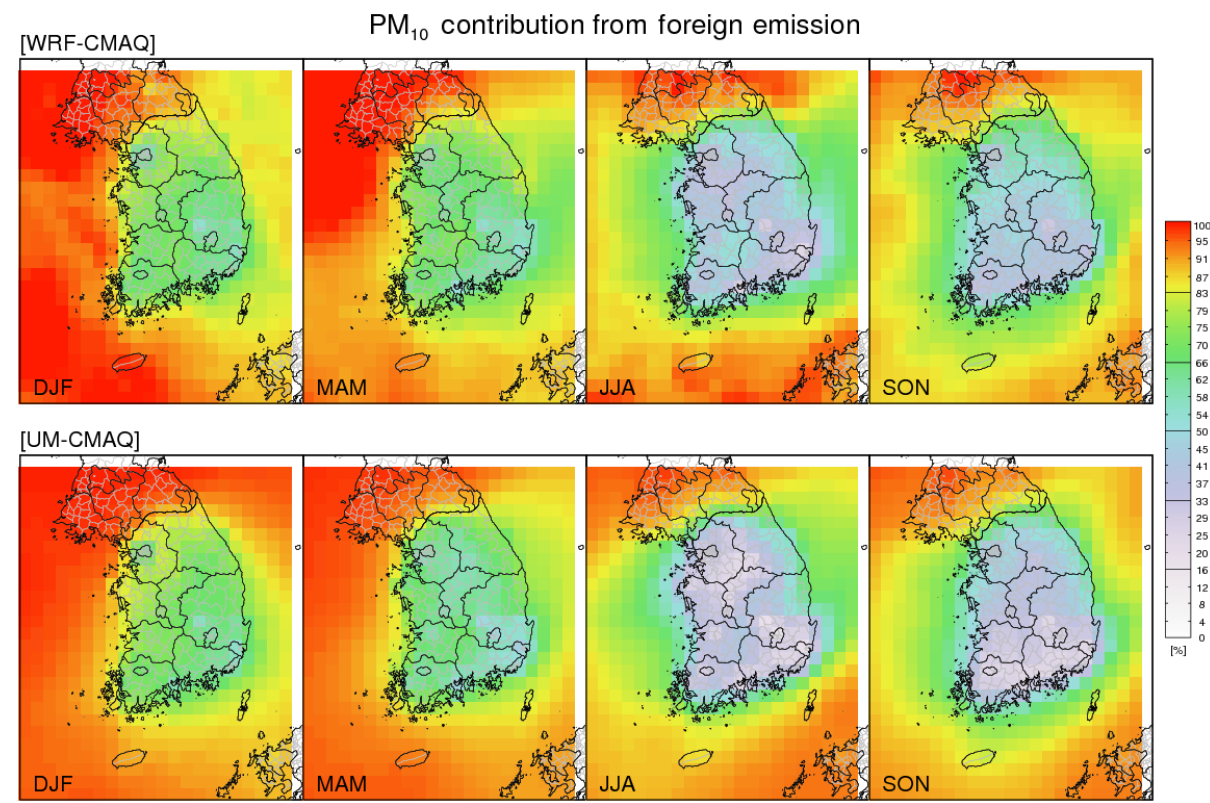
Figure 7. Quarterly average foreign emissions contributions, as simulated by the WRF-CMAQ and UM-CMAQ